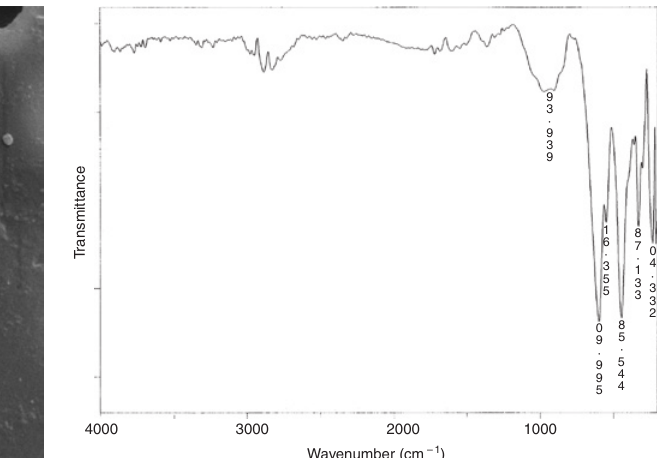
Figure 10: FT-IR spectrum of nanoparticles obtained at 850 ° C.